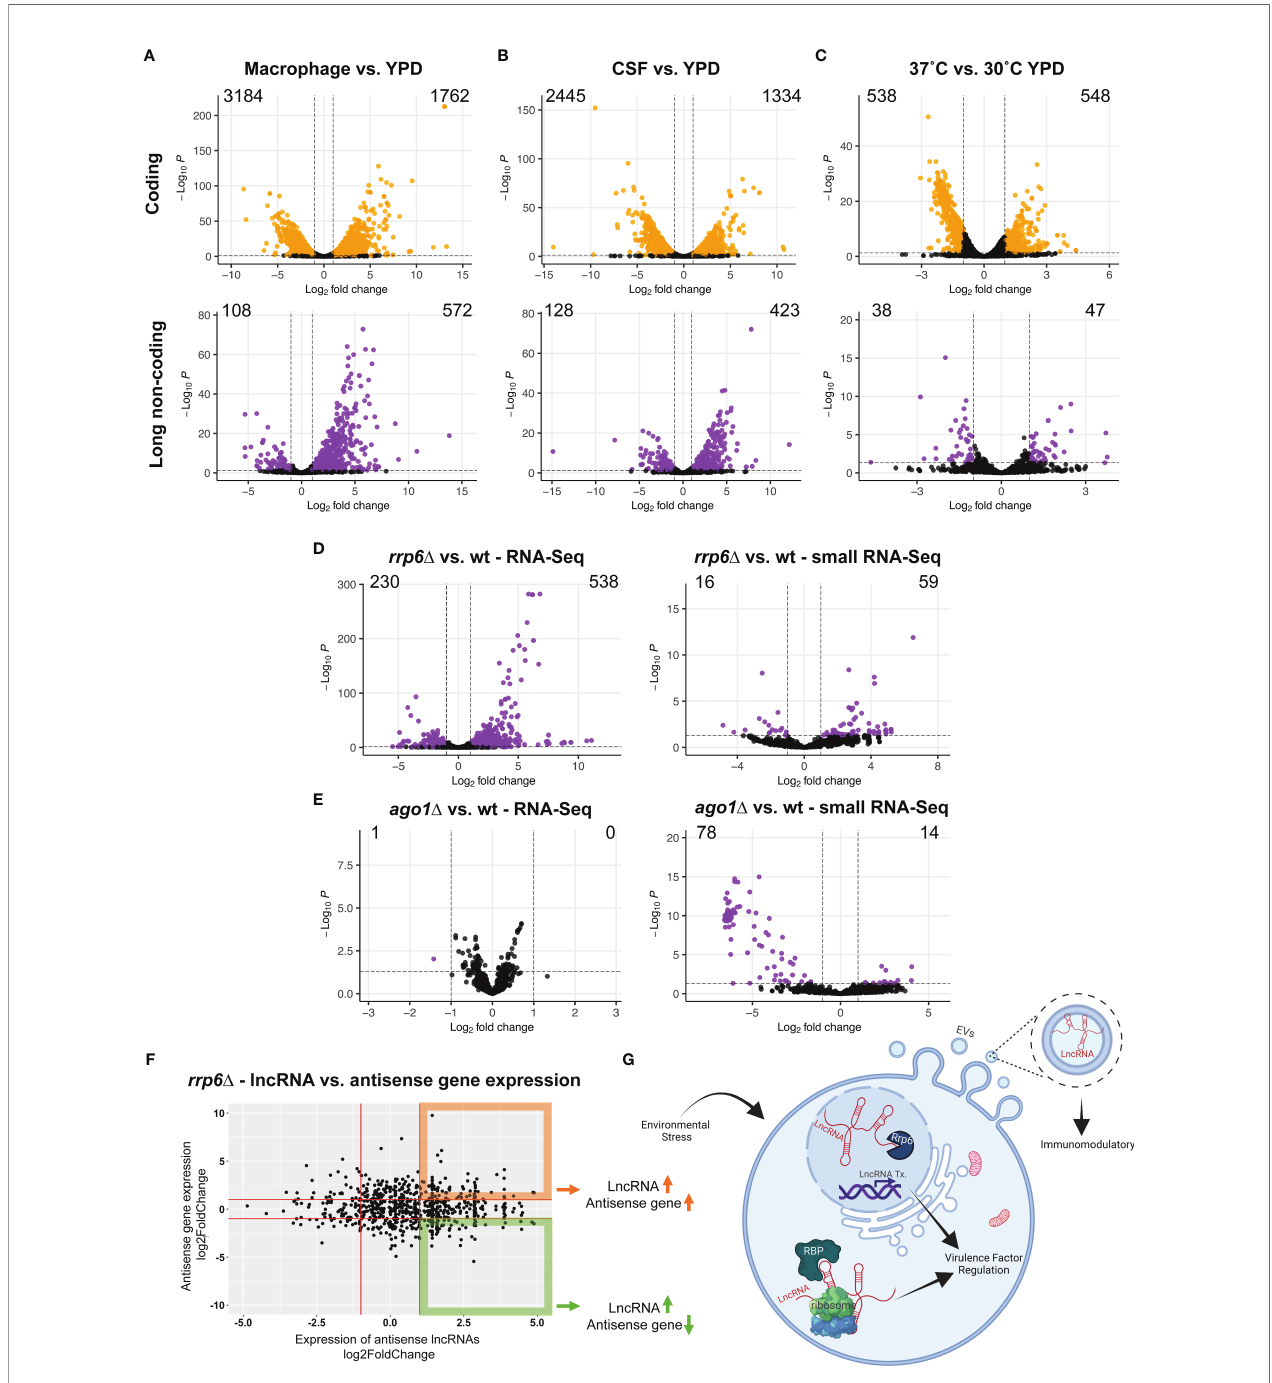
FIGURE 2 | Long non-coding RNA expression under conditions that mimic the host environment and in gene deletion mutants. We utilized the public datasets to investigate the expression of lncRNAs under conditions that are relevant to infection. These conditions include in vitro J774A macrophage infection (A) , CSF (B) , and 37 ˚ C compared to 30 ˚ C in YPD (C) . The number of upregulated and downregulated genes were noted on each graph for both coding (orange) and non-coding (purple) genes. We then show the impact of RRP6 (D) and AGO1 (E) gene deletions on lncRNA expression as well as changes in the expression of small RNAs that map to full-length lncRNAs. We show the expression of antisense lncRNAs and antisense protein-coding transcripts in the rrp6 D (F) . RNA sequencing data were obtained from GSE136879, GSE121183 and GSE128009. GSE136879 data fi les were trimmed and mapped to the H99 genome using STAR alignment and gene expression analysis was performed using RSEM and DeSeq2. GSE121183 and GSE128009 data were analyzed for ncRNA expression using the supplementary tables provided by the authors of these studies. (G) Graphical summary/model. LncRNAs can have unique functions in distinct cellular and extracellular compartments that impact pathogenesis and immune modulation. The graphical summary is created using